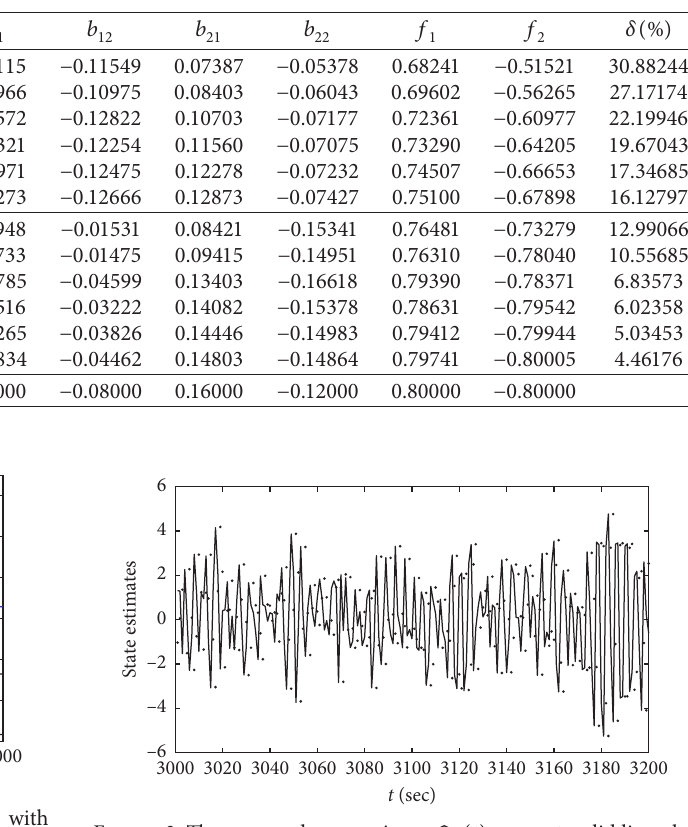
( t ) versus t ; solid line: the 2 ( t ) 2